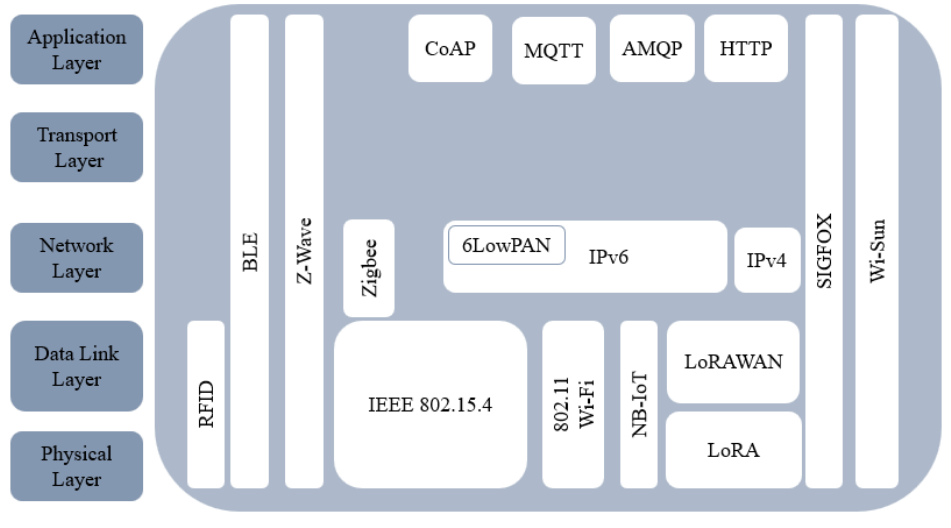
Figure 2. IoT Stack